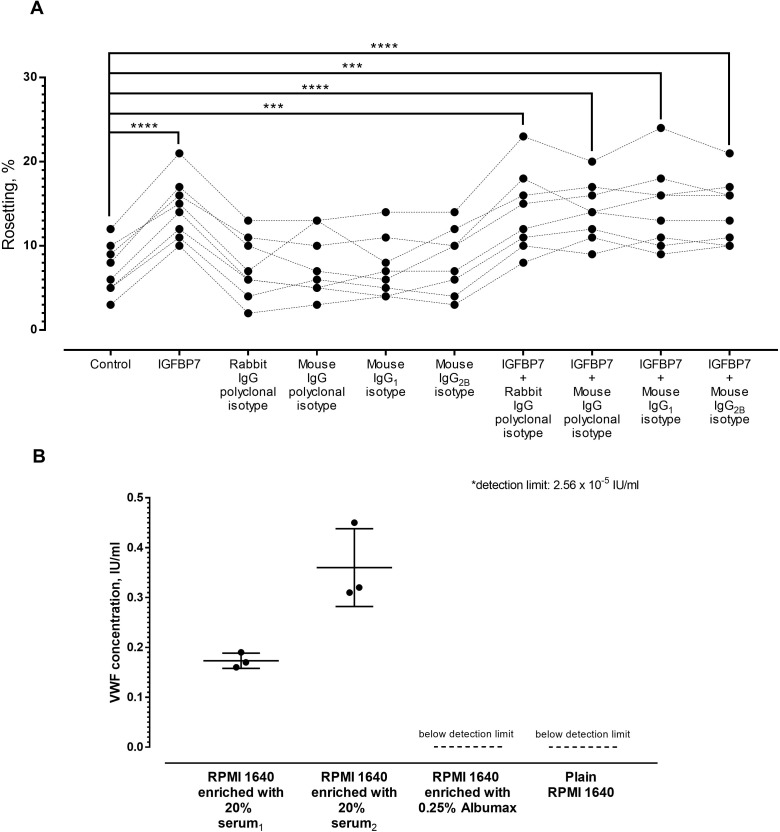
Control experiments.(A) Rosetting of P. falciparum lines (n = 8) under different conditions. One-way ANOVA with Tukey’s test was conducted. IGFBP7 stimulated rosetting (p<0.0001). No significant difference was found between the control and rabbit IgG polyclonal isotype (p>0.9999), mouse IgG polyclonal isotype (p=0.9721), mouse IgG1 isotype (p>0.9999), and mouse IgG2B isotype (p=0.3379). The rosette-stimulatory effect by IGFBP7 was not hampered by these antibody isotypes when compared with the rosetting from the control group (p=0.0007 for IGFBP7+ rabbit IgG polyclonal isotype; p<0.0001 for IGFBP7 + mouse IgG polyclonal isotype, p=0.001 for IGFBP7 + mouse IgG1 isotype, and p<0.0001 for IGFBP7 + mouse IgG2B isotype). (B) Quantitation of VWF in media used in this study. Media enriched with human AB sera from two major sources for our research, Albumax II and plain medium control were recruited for ELISA (triplicates done on each group, mean and SD shown). Media enriched with serum1 showed a VWF level of 0.1733 IU/ml (SD 0.0153), whereas media enriched with serum2 had 0.36 IU/ml (SD 0.0781) VWF. VWF levels of Albumax II-enriched medium and plain medium were below detection limit of the ELISA system used.